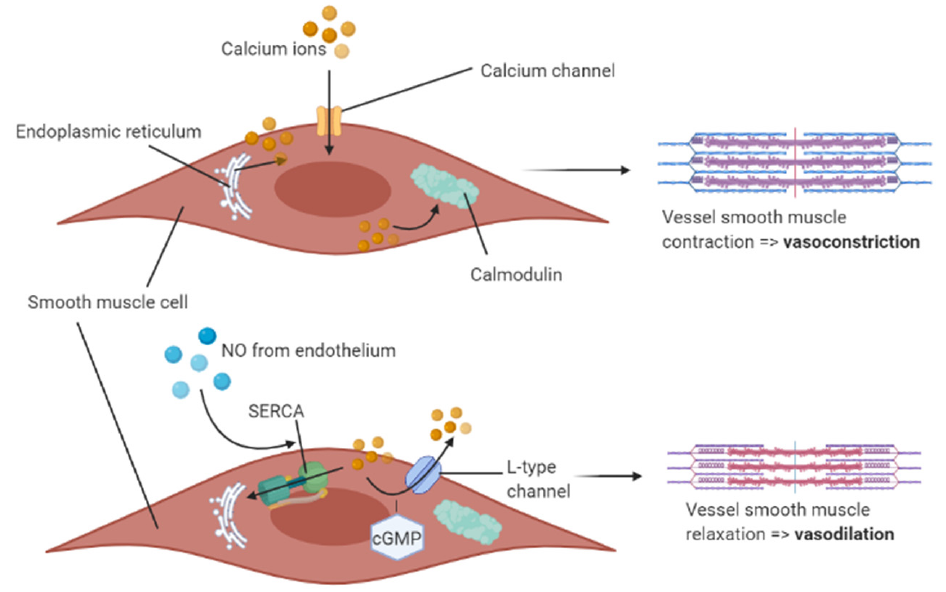
Figure 1. Antagonistic mechanism of NO-mediated vasodilatation and Ca 2 + -mediated vasoconstriction in the smooth muscle cell layer of blood vessels. Calcium ions bind to calmodulin in the cell cytosol, which triggers constriction of the smooth muscle cell lining the vessel. The endothelium secretes NO which prevents this pathway via two different mechanisms in the cell cytosol: SERCA-mediated and cGMP-mediated pathways. NO = nitric oxide; SERCA = sarcoendoplasmic-reticulum calcium ATPase; cGMP = cyclic guanosine monophosphate. Created on BioRender.com (BioRender).